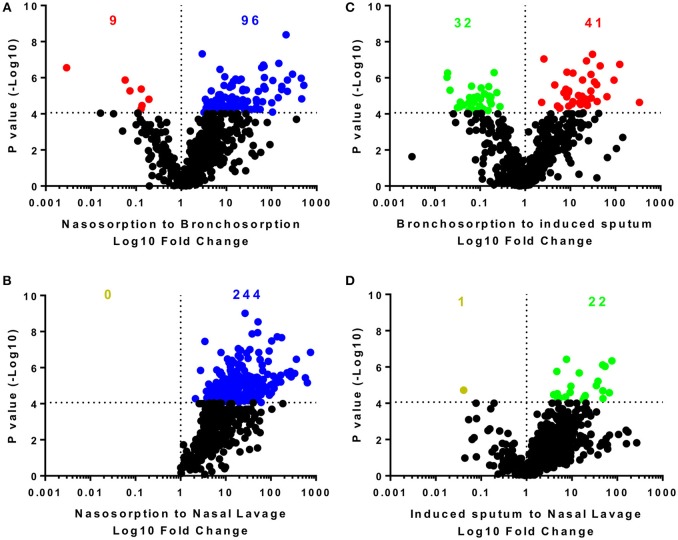
Distribution of individual biochemicals across sampling techniques. Pairwise comparisons of individual biochemicals were made for different sampling techniques either using similar methodologies (A,D) or sites (B,C). Colored dots and numbers represent biochemicals significantly greater (blue nasosorption, red bronchosorption, green induced sputum, yellow nasal lavage) with a p-value measured by t-test cut off at 8 × 10−5 to reflect multiple testing.